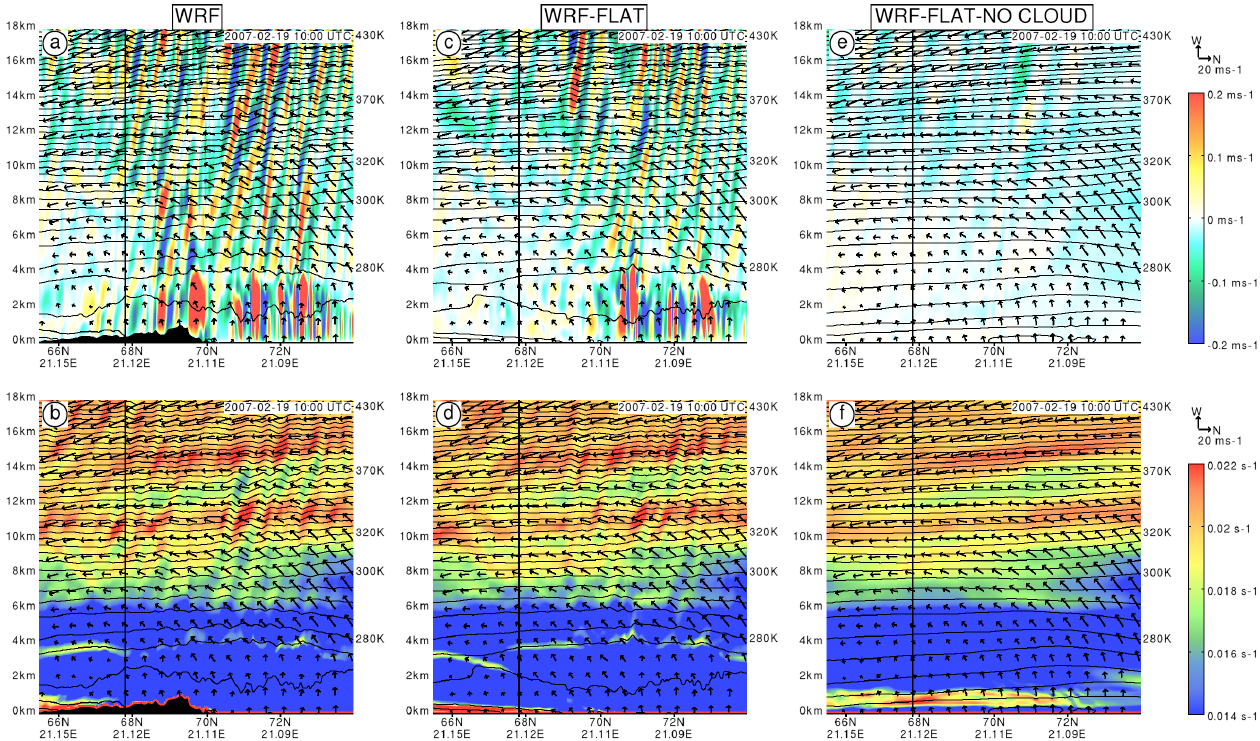
Fig. 6. (a) – (f) Vertical south–north cross sections at the location indicated by the line (A–B) in Figs. 2b and 5, for the vertical wind component ( a , c , e ) and buoyancy frequency ( b , d , f ), the horizontal wind (arrows) , and isentropes (black contours) at 10:00UTC on 19 February 2007, from the WRF simulations. The horizontal axis gives the latitude and the vertical axis gives the altitude in km. The horizontal distance between wind arrows is 53km. The profile of the Scandinavian ridge crossed by this meridional cross section is shaded in black, and the ESRAD location is indicated by the black vertical line. The buoyancy frequency and vertical wind scales are given by the colour bars to the right. The horizontal wind scale is given by the arrows above the colour bars. (a) , (b) Simulation with clouds and orography; (c) , (d) simulation with clouds but without orography; (e) , (f) simulation without clouds and without